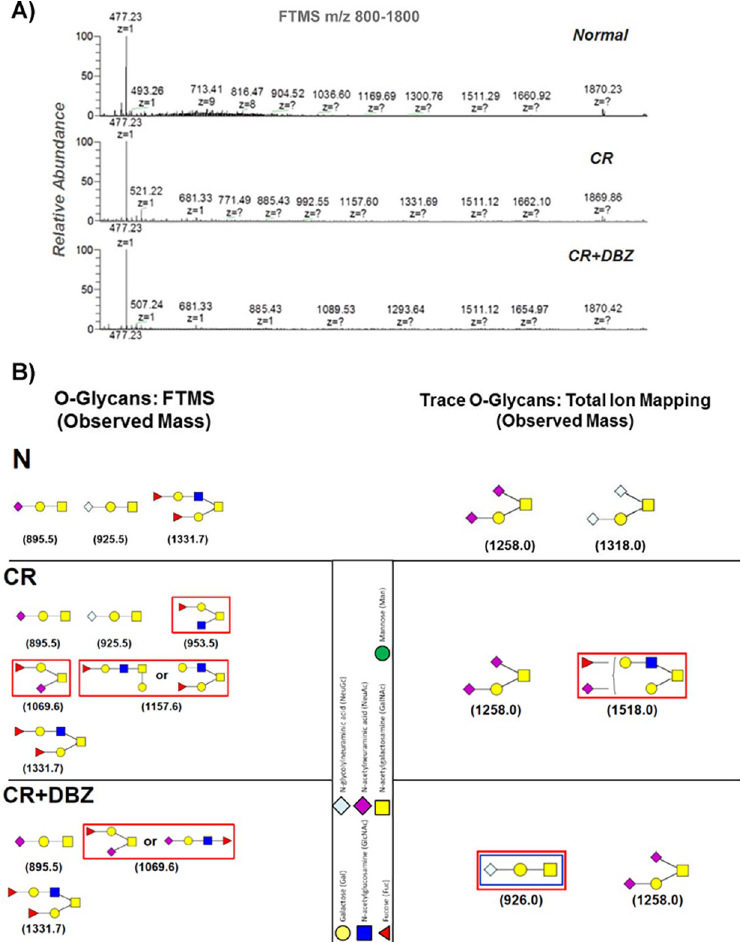
Fig 2. Analysis of colon mucus samples for O -linked glycans. A. FTMS m/z 800–1800 of mucus samples. After removing the N-glycans from the proteins with PNGase F, the O -glycans were removed through beta-elimination procedures. The glycans were then purified again with a C18 column, permethylated, purified again, then analyzed with MALDI and NSI-MS. Numerous O -glycans are detected in the samples. Additionally, a number of trace glycans are detected as a result of Total Ion Mapping (TIM). B. O -Glycans Detected by FTMS. Representative O - structures assigned are “proposed” structures based on the fall and tandem MS data observed, as well as common biosynthetic pathways common to mammalian and (if possible) the species Mus Musculus . Red rectangles represent differences between normal (N) and CR-infected (CR) mucus samples while blue rectangles represent mucus glycans unique to CR+DBZ-treated